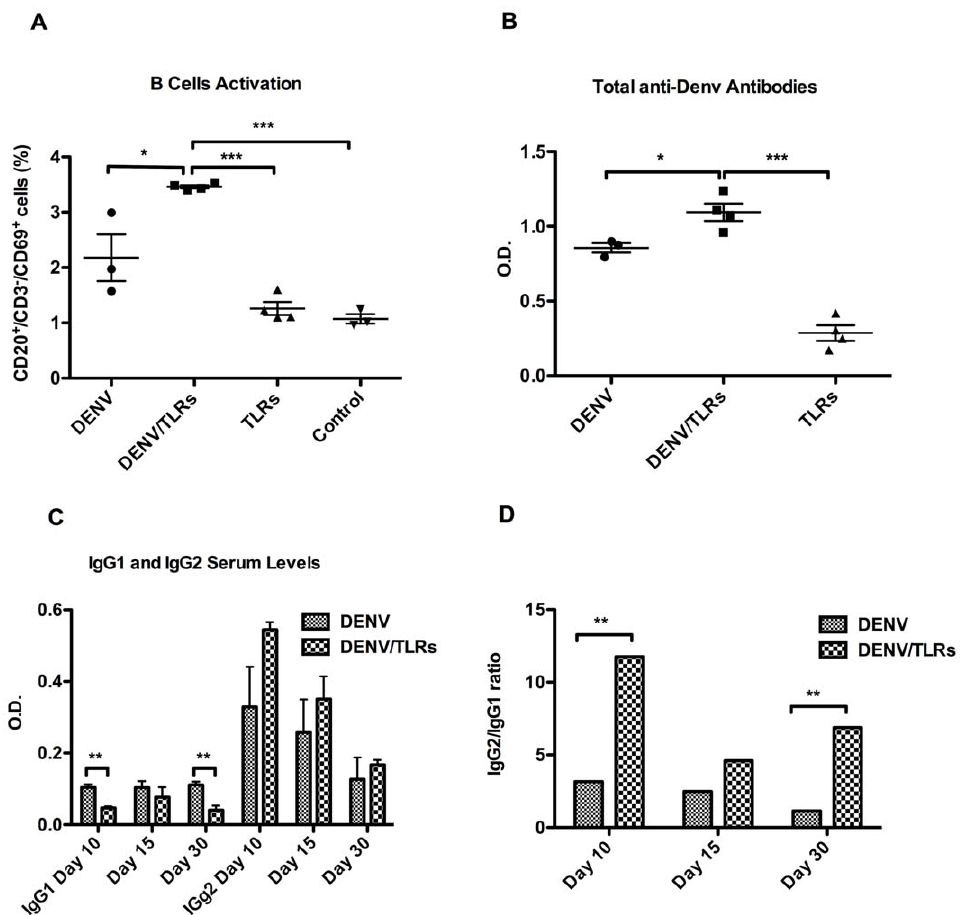
Figure 4. TLR3-7/8 stimulations in synergism with DENV induce quantitative and qualitative modifications of the humoral response. A: Ten days after the infection, the frequency of activated B cells was significantly higher in DENV/TLR group when compared to all other groups, showing a synergistic effect of DENV with the TLR agonists in this activation. DENV alone was able to induce activation of B cells when compared to the TLR and Control groups. However, in our model, TLR agonists alone were not sufficient to induce B-cell activation. B: The activation profile of B cells correlates with the levels of anti-DENV antibodies. Antibody levels were significantly higher in the DENV/TLR group compared to the DENV group. C: As early as 10 days after infection and coincident with activation of B cells, the switch to IgG1 was significantly diminished in the DENV/TLR group. This difference had disappeared by 15 days after the infection, but it was re-established on day 30. D: Although antibody O.D. values were limited, the difference in the IgG1 and IgG2 levels translated into a significant increase of the IgG2/IgG1 ratio ( . 11 and 6 times on days 10 and 30 after the infection, respectively). Asterisks denote significant differences, (*) p , 0.05, (**) p , 0.01, and (***) p , 0.001.